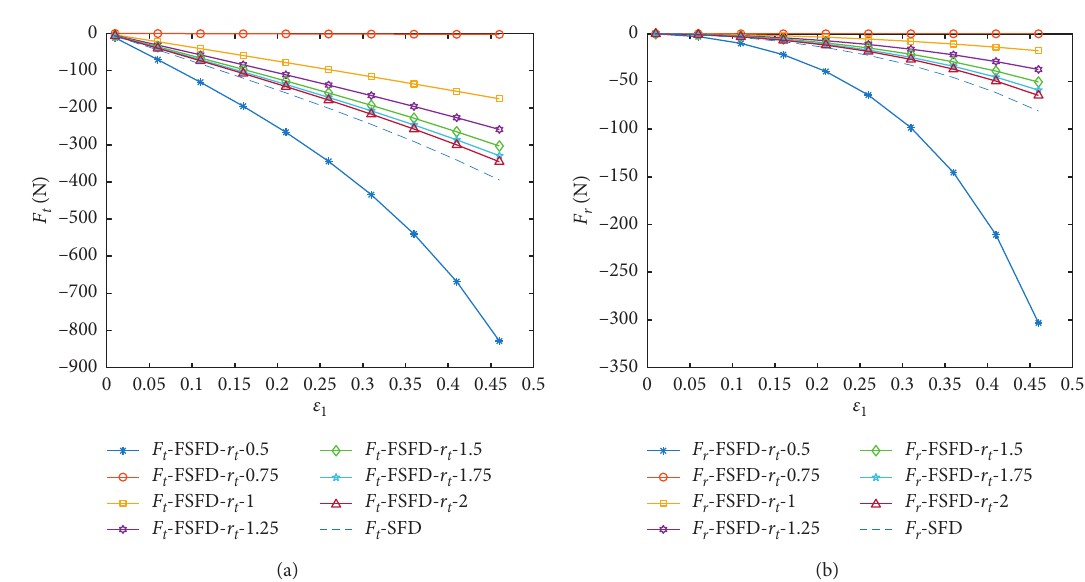
Figure 5: The influence of r